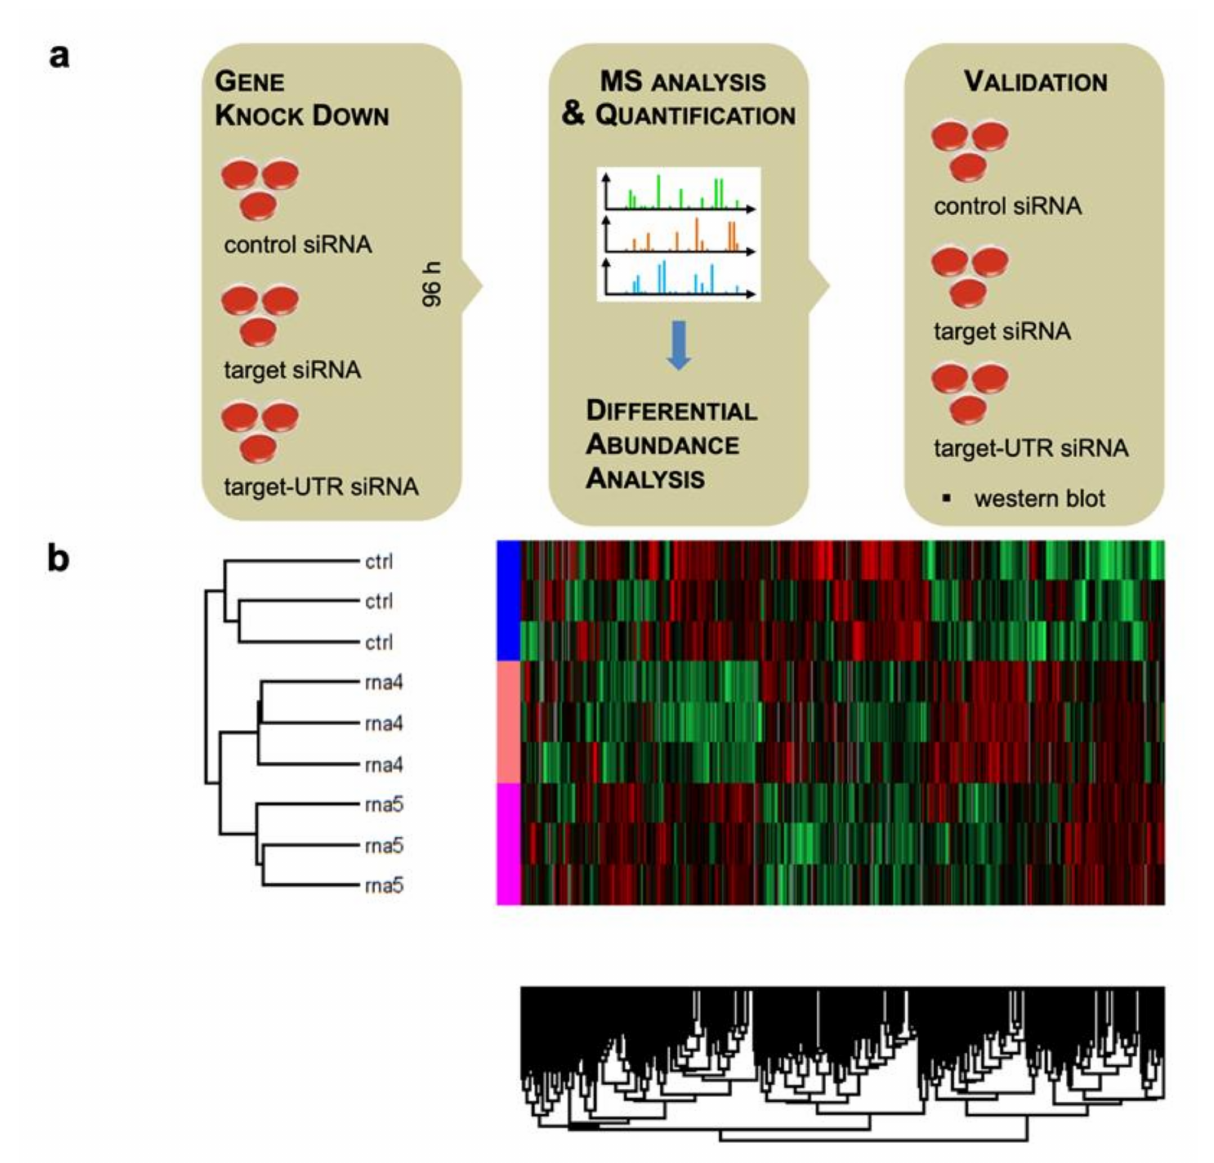
Figure 2. Experimental strategy and representative heat map. ( a ) The experimental strategy was as follows: siRNA- mediated gene silencing using two different siRNAs for each target and one non-targeting (control) siRNA, respectively, with three replicates for each siRNA for 96 h; label-free quantitative analysis of the total cellular proteome; differential protein abundance analysis to identify negatively affected proteins (i.e., putative clients of the target) and positively affected proteins (i.e., putative compensatory mechanisms); validation by western blot. ( b ) Heat maps visualize clusters of proteins that were positively affected following treatment with both siRNAs directed against target mRNA or with non-targeting (control) siRNA, or that were negatively affected following treatment with both siRNAs, or that represent variations between siRNAs. Red indicates positively affected proteins, green indicates negatively affected proteins. The representative heat map shows results from an experiment where SEC61A1 was the